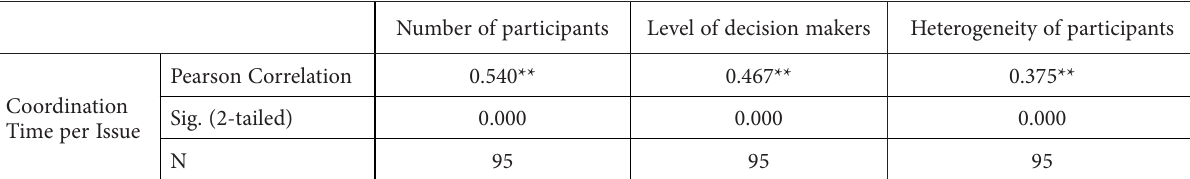
Table 3. Correlation analysis between issues resolving the coordination time, heterogeneity of participants,